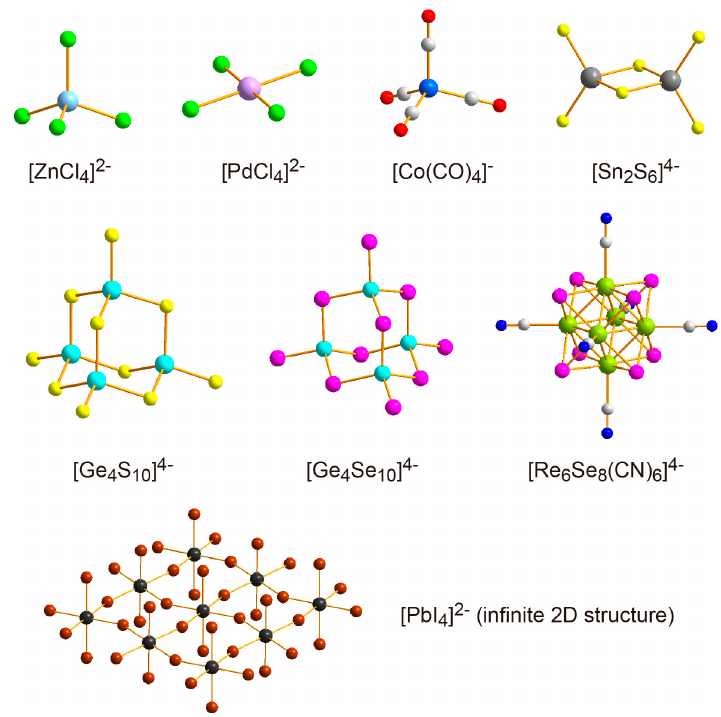
Figure 5. Several discrete inorganic anions employed to construct hybrid surfactant single crystals with cationic surfactants. Oxide cluster anions are represented separately in Figure 8.